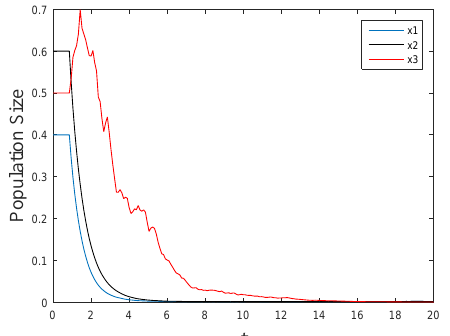
Figure 1. The solution to x i , i = 1,2,3 are 1st moment extinction. Case 2. For Model (2), set the initial value ( x 10 , x 20 , x 30 ) T = ( 1, 1.5, 2 ) T . Choose the parameter r 1 = 1, r 2 = 1, r 3 = 0.2, a 11 = 0.22, a 12 = 0.7, a 21 = 0.1, a 22 = 0.2, a 23 = 0.51,